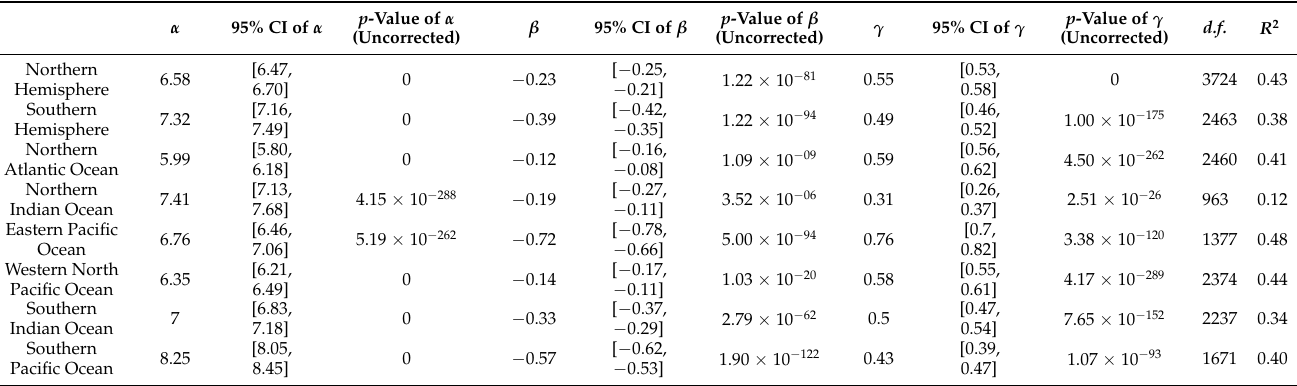
Table A2. Statistical significance of the relationship between tropical cyclone rainfall and maximum wind speed and